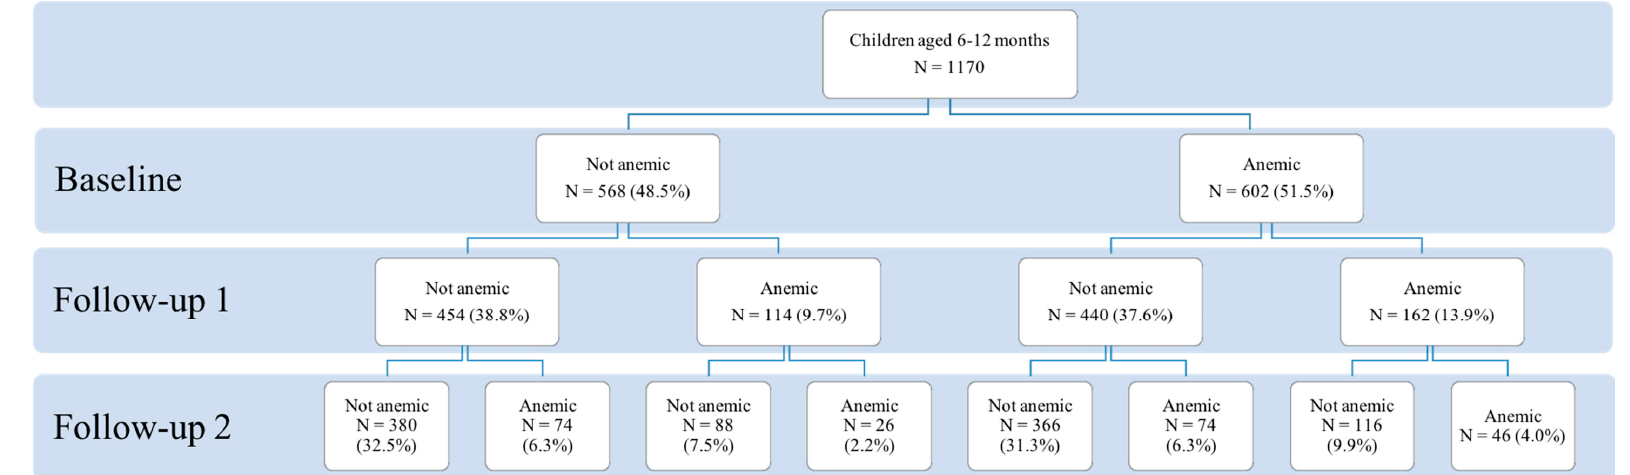
Figure 1. Crossover between normal and anemic states during the three waves of data collection. Data source: Author’s survey.